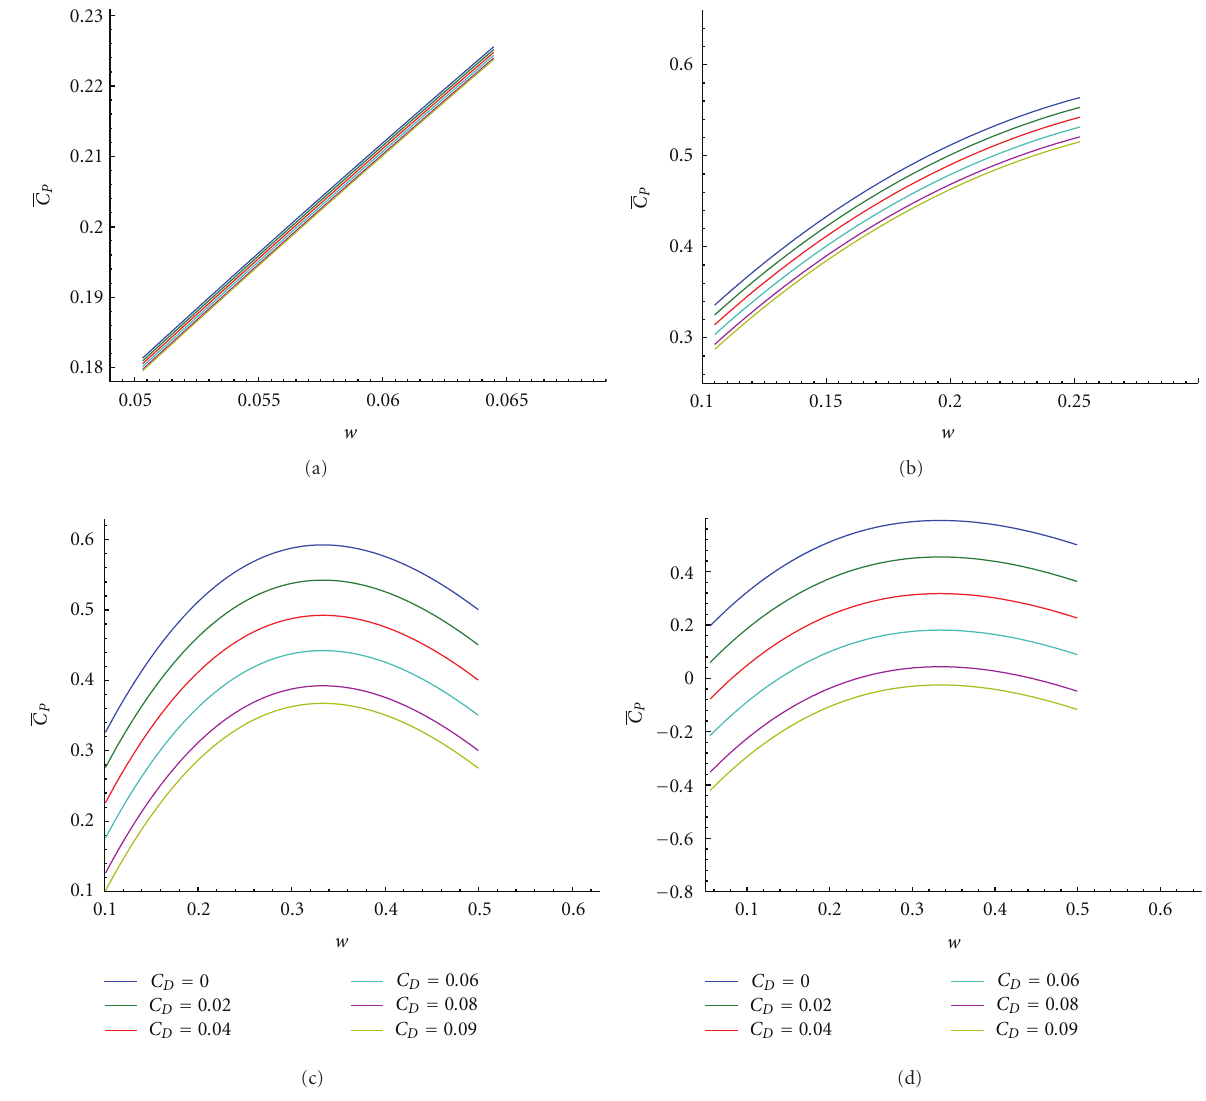
Figure 10: (a) C P versus w for J = 1, (b) C P versus w for J = 3, (c) C P versus w for J = 5, and (d) C P versus w for J =